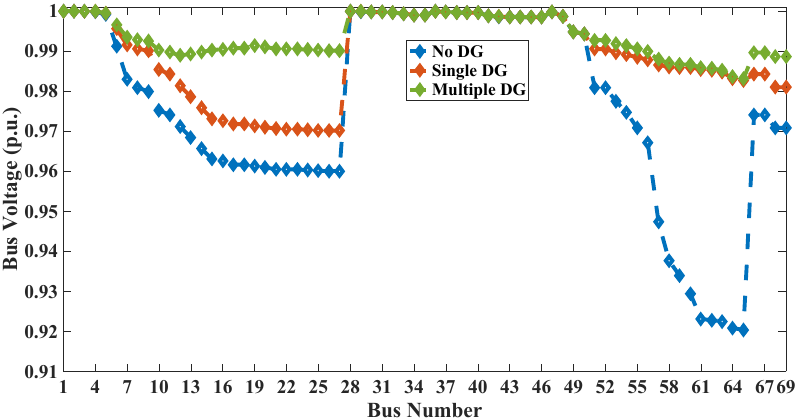
Figure 8. Variation of bus voltage before and after placement of DG for Residential Load.